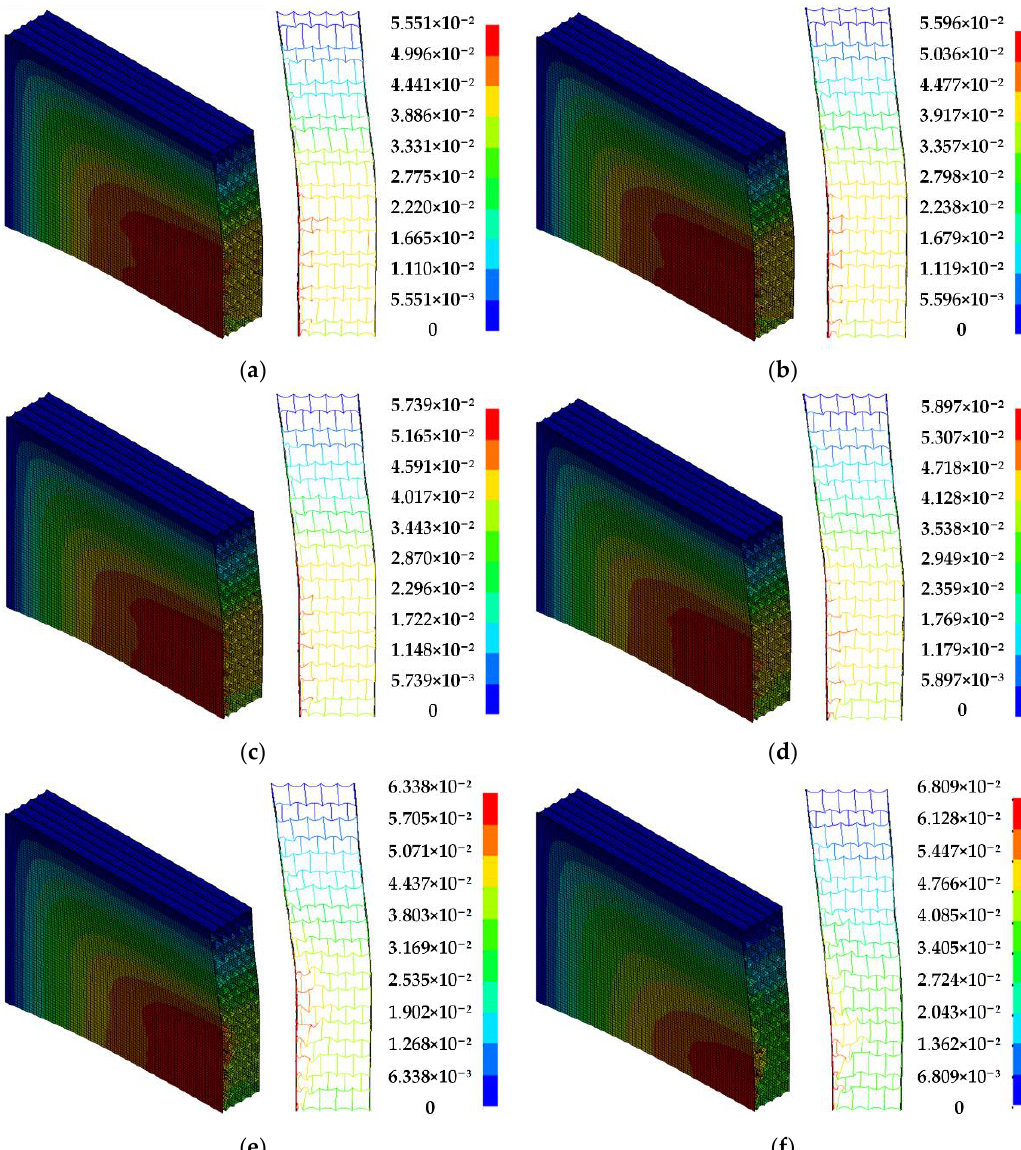
Figure 18. Deformation of different aspect ratio ( l / h ). ( a ) 1.0; ( b ) 1.1; ( c ) 1.2; ( d ) 1.3; ( e ) 1.4; and ( f )